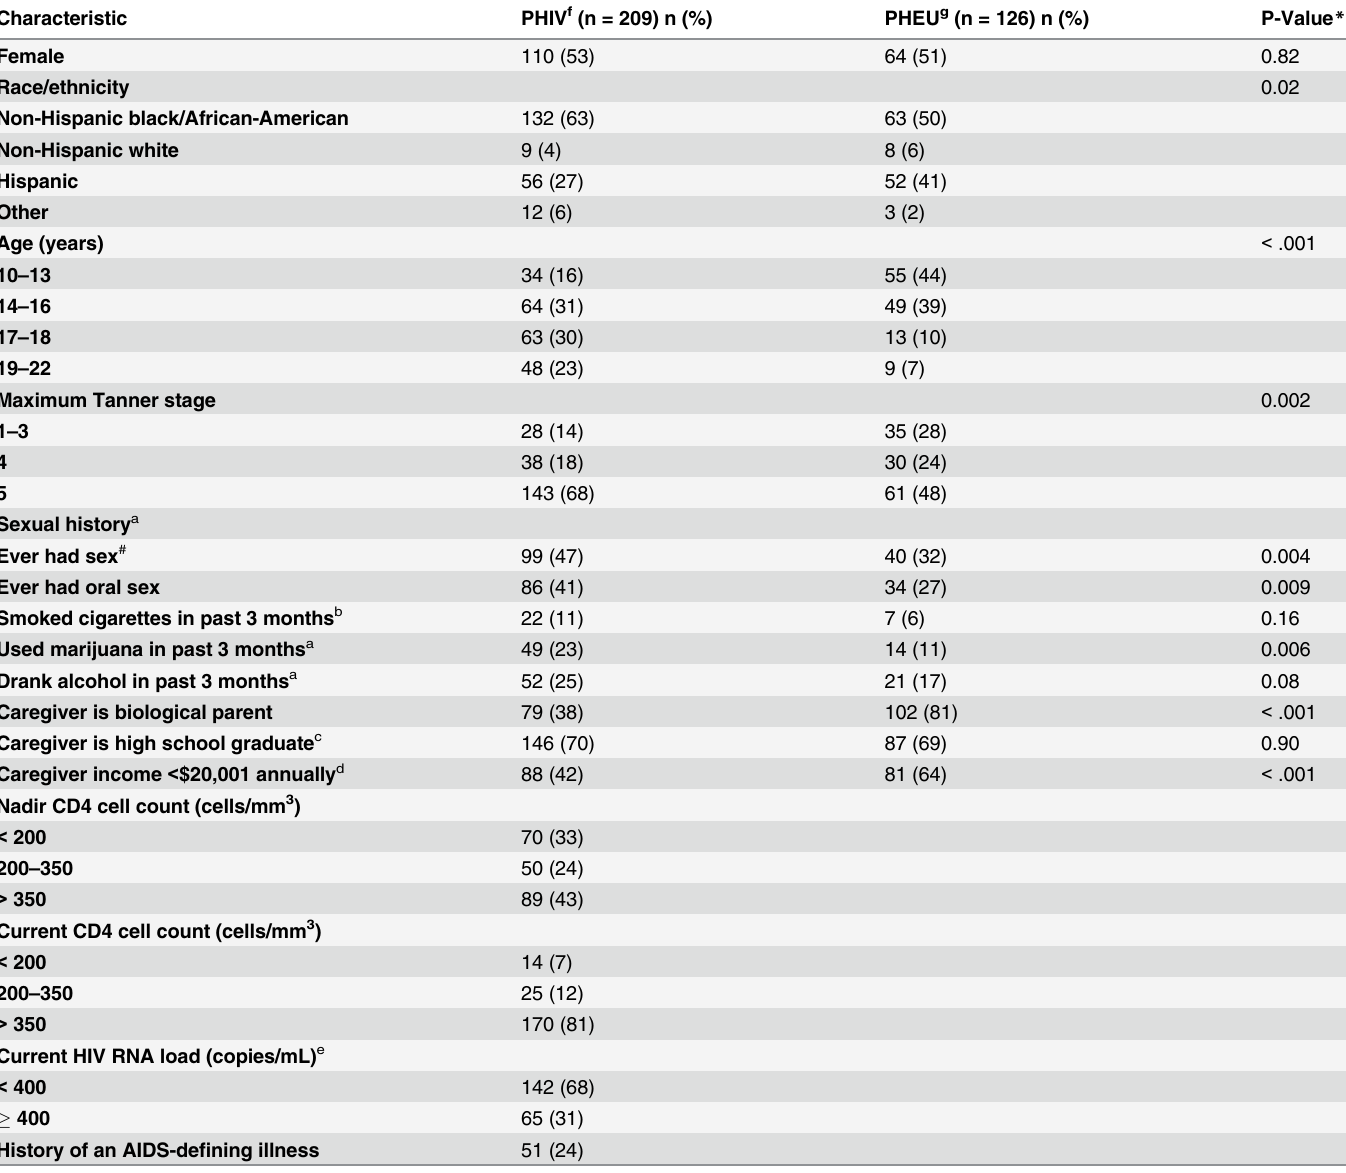
Table 1. Socio-demographic and health characteristics at oral health exam by HIV status among participants in the Pediatric HIV/AIDS Cohort Study (PHACS) Oral Health Substudy.